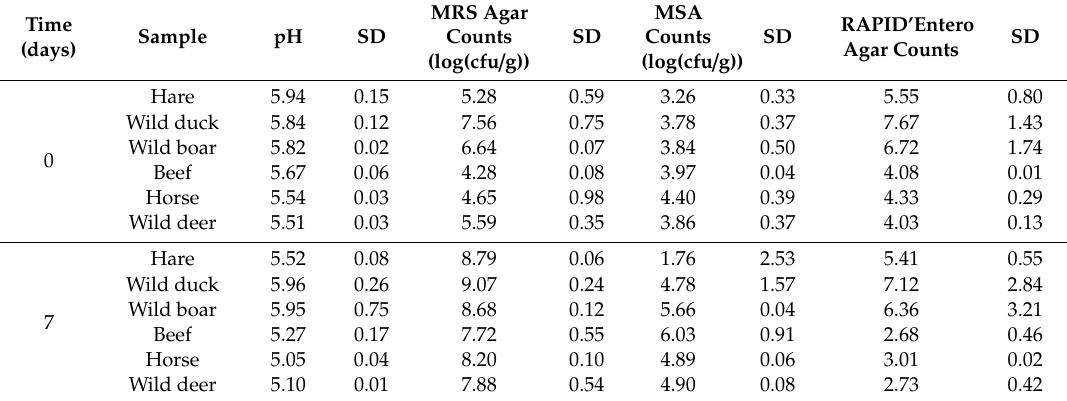
Table 3. Community dynamics of the microbiota of various naturally fermented, less conventional meat types and the resulting pH course after 0 and 7 days of fermentation, displayed as average of two biological replicates carried out for each meat type, and standard deviation (SD). The bacterial counts on MRS agar, MSA, and RAPID (cid:48) Entero agar are expressed as log (cfu / g). Time